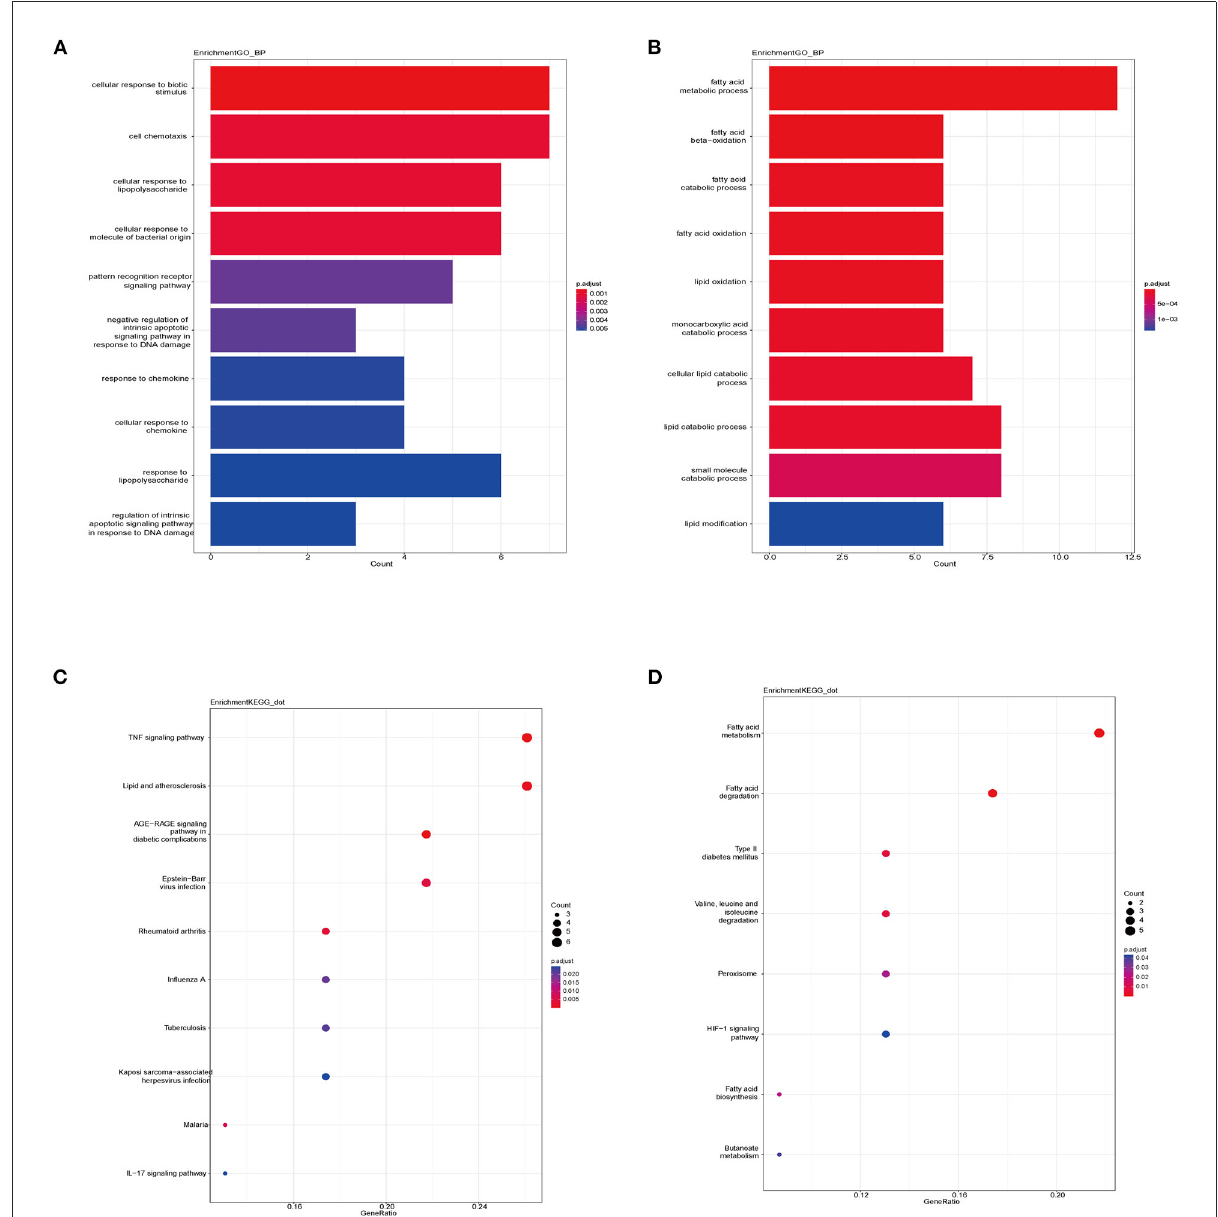
FIGURE3 Functional enrichment of differential expression genes (DEGs). (A) Biological process (BP) of up-regulated DEGs in gene ontology (GO) analysis. (B) BP of down-regulated DEGs in GO analysis. (C) Pathways of up-regulated DEGs in Kyoto encyclopedia of genes and genomes (KEGG) analysis. (D) Pathways of down-regulated DEGs in KEGG